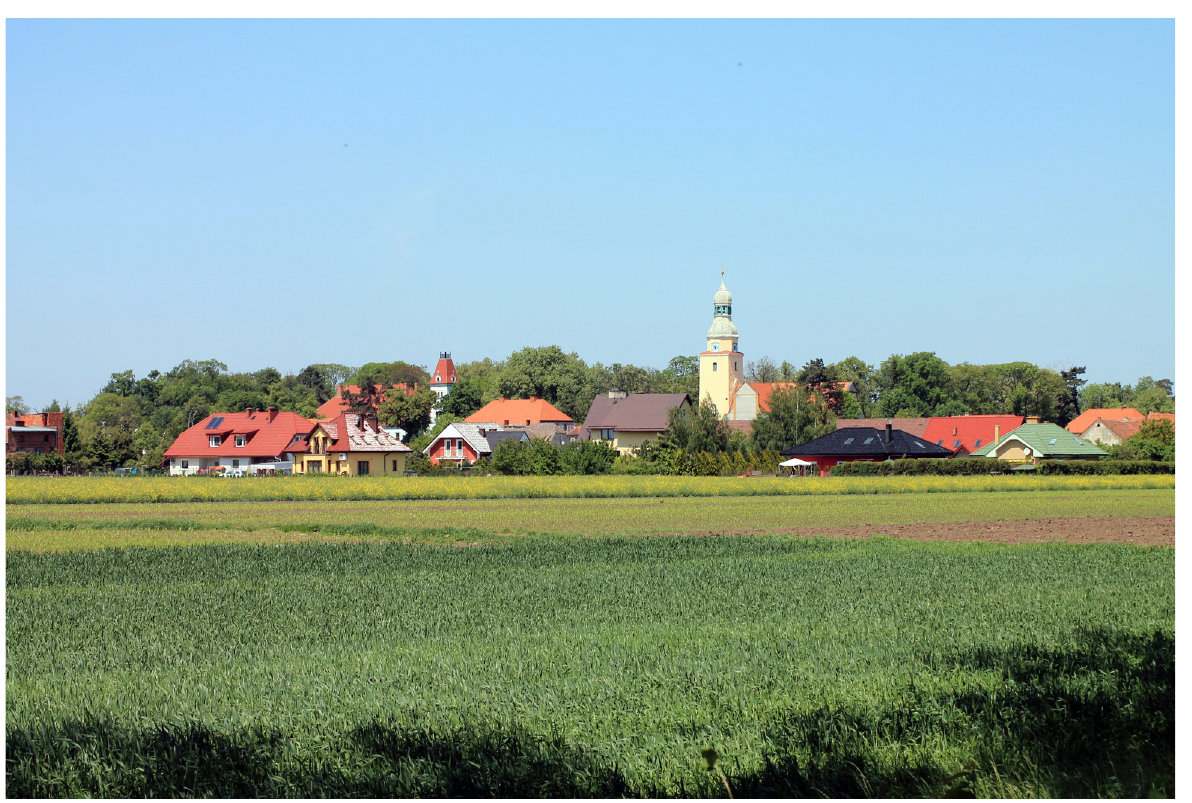
Fig. 4. The tower of the parish church in Borek Strzeliński dominates in the panorama of the village from the